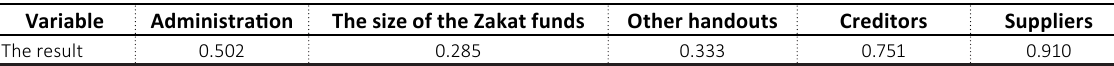
Table 10. Results of the chi-square test